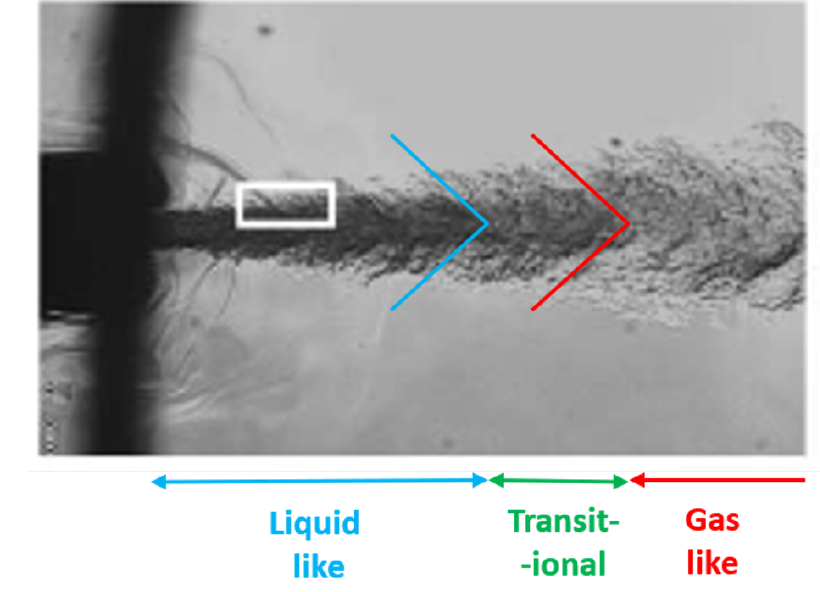
Figure 6. Visualisation of cryogenic N 2 injected into a chamber maintained at a supercritical pressure of 9 MPa and supercritical temperature of 298 K by Chehroudi [24]. The extent of the different phase domains is located